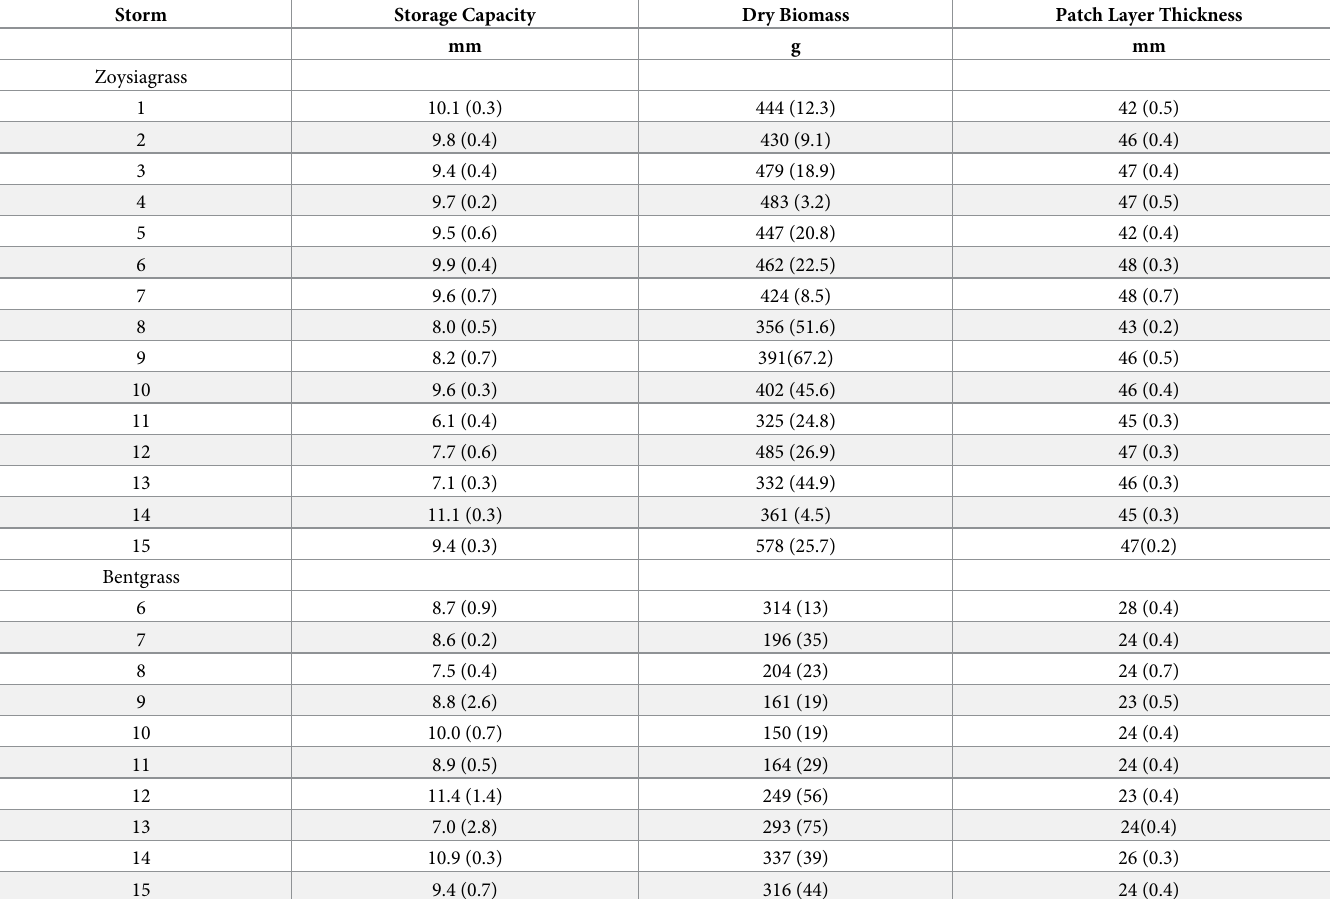
Table 2. Storm, storage capacity, dry biomass, thatch layer for turfgrass patches of zoysiagrass and bentgrass. Value between parenthesis represent the standard error of the